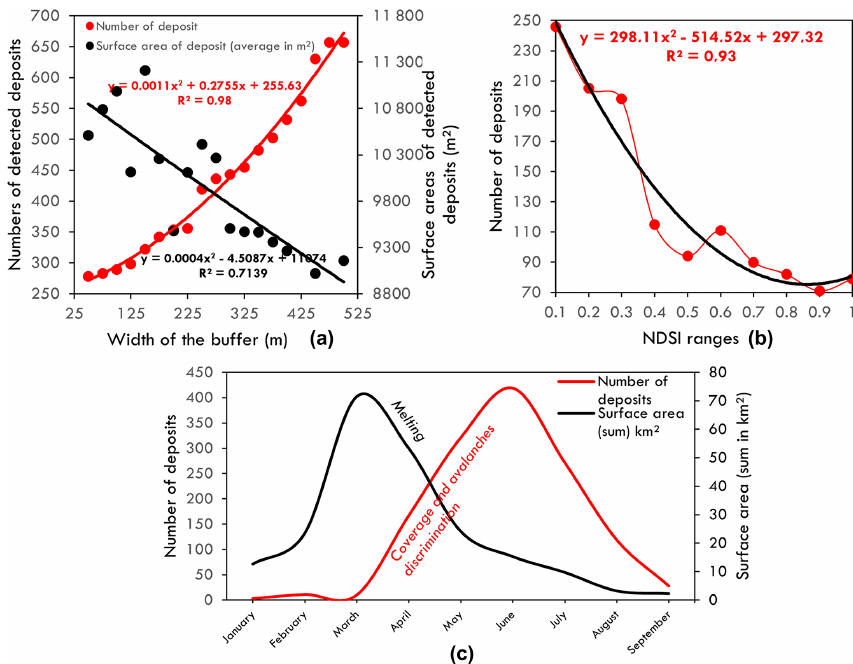
Figure 12. Sensitivity tests of SAFE for number and surface areas of detected avalanche depositional zones: (a) width of buffer, (b) NDSI ranges, and (c) dates of